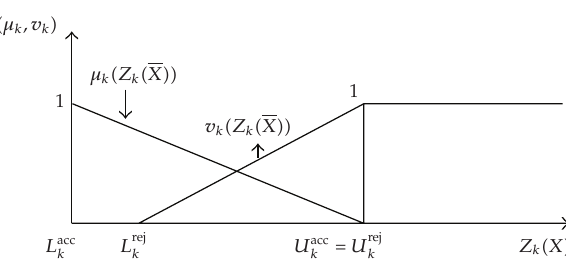
Figure 1: Membership and nonmemebership functions of the objective